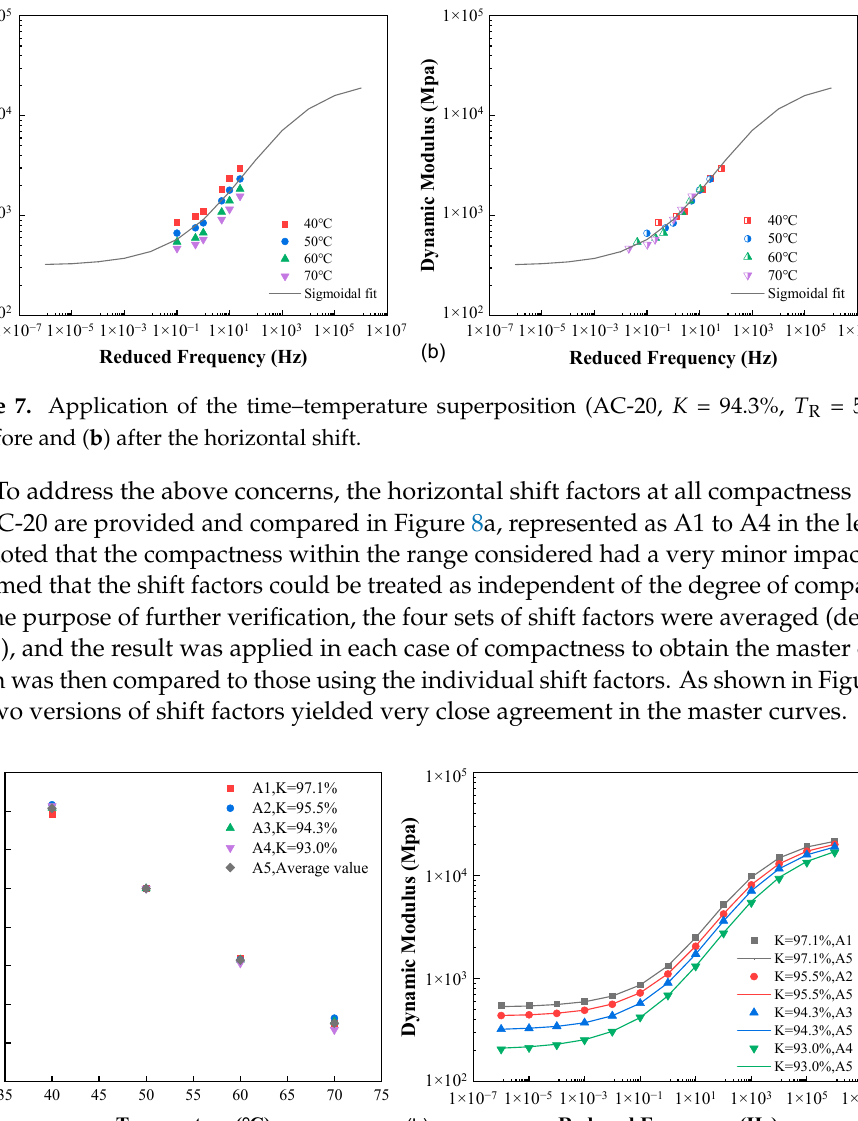
Table 7. The SSR results (%) for the use of individual and averaged shift factors.